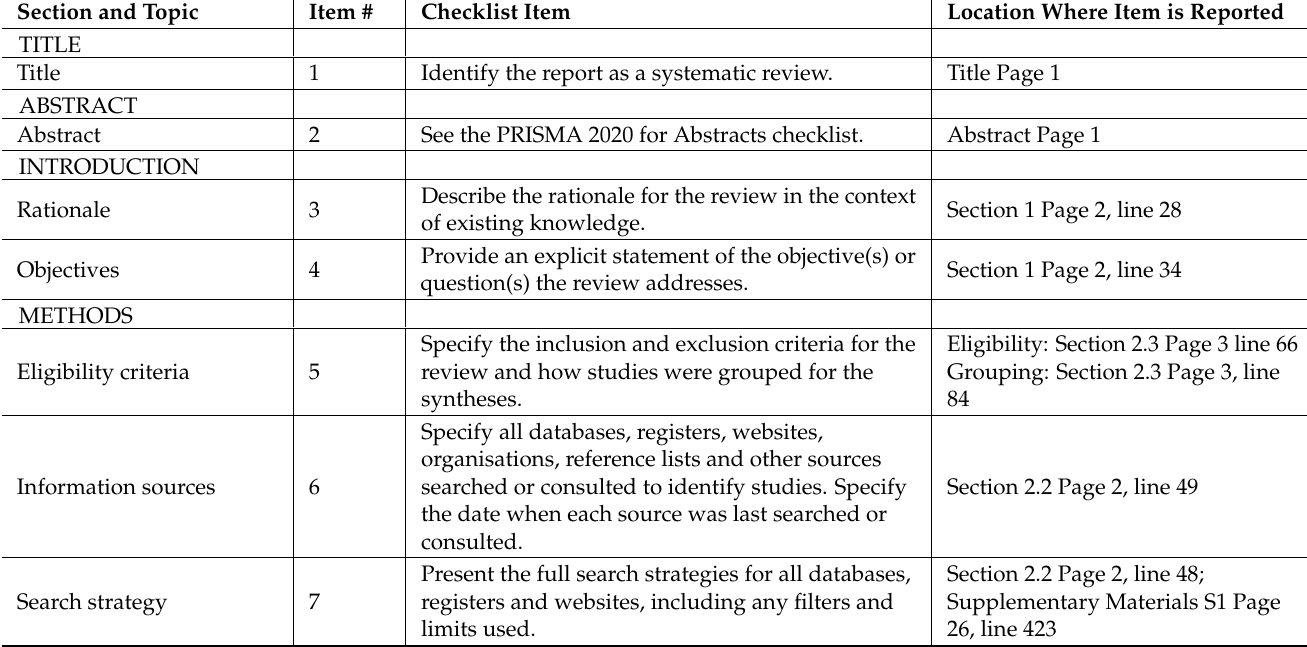
Table A1. PRISMA 2020 Checklist for Systematic Reviews